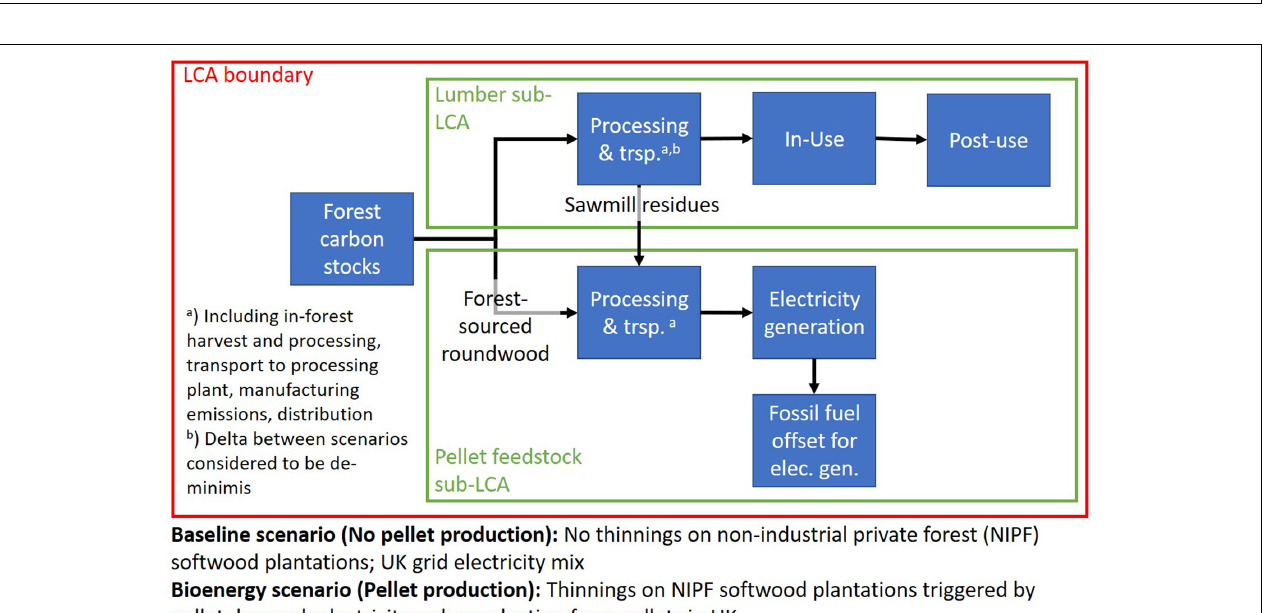
FIGURE 2 | C LCA accounting elements (blue) and boundaries (red, green) as deployed in this study. A full C LCA was run for both the baseline and bioenergy scenarios, including both sub-LCAs (lumber and pellet feedstock). C in durable wood products (as shown in the Lumber sub-LCA) was tracked for the baseline scenario as well because both scenarios impact wood harvested for lumber due to differences in forest management.